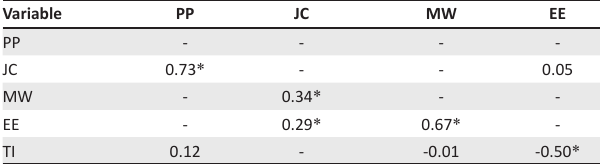
TABLE 3: Factor loadings of hypothesised